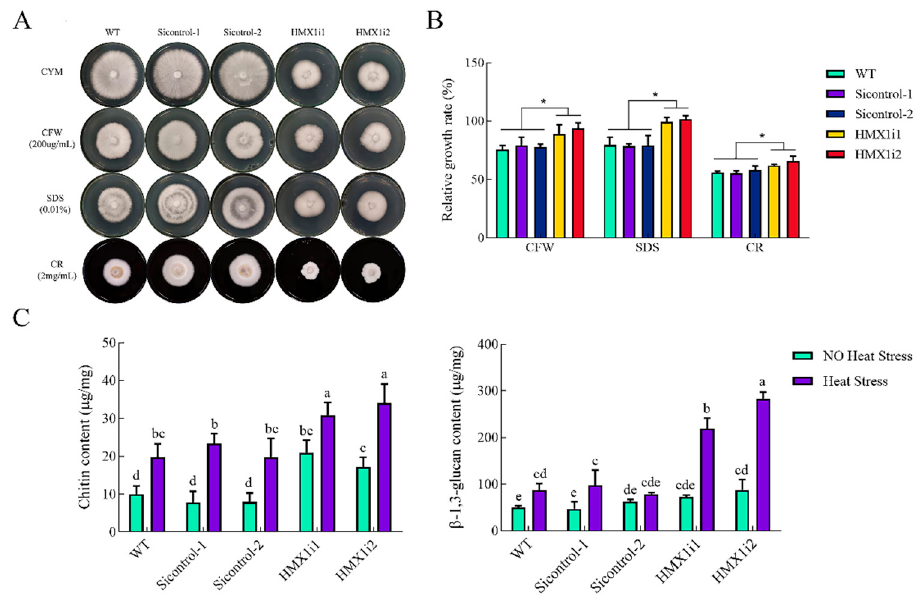
Figure 6. Effects of Silencing HMX1 on cell wall susceptibility and components. ( A ) WT, Sicontrol, and HMX1 silenced strains cultured on medium supplied with 200 µ g/mL CFW, 0.01% SDS, or 2 mg/mL CR, respectively, ( B ) and their corresponding relative growth rate. ( C ) The chitin and glucan content in the mycelia of WT, Sicontrol, and HMX1 silenced strains under heat stress or non-heat stress, respectively. All calculated results are expressed as mean ± standard deviation, and these English letters of “a”, “b” and “c” are indicated significant differences among different treatments ( p < 0.05). Significance was accepted at * p <0.05.